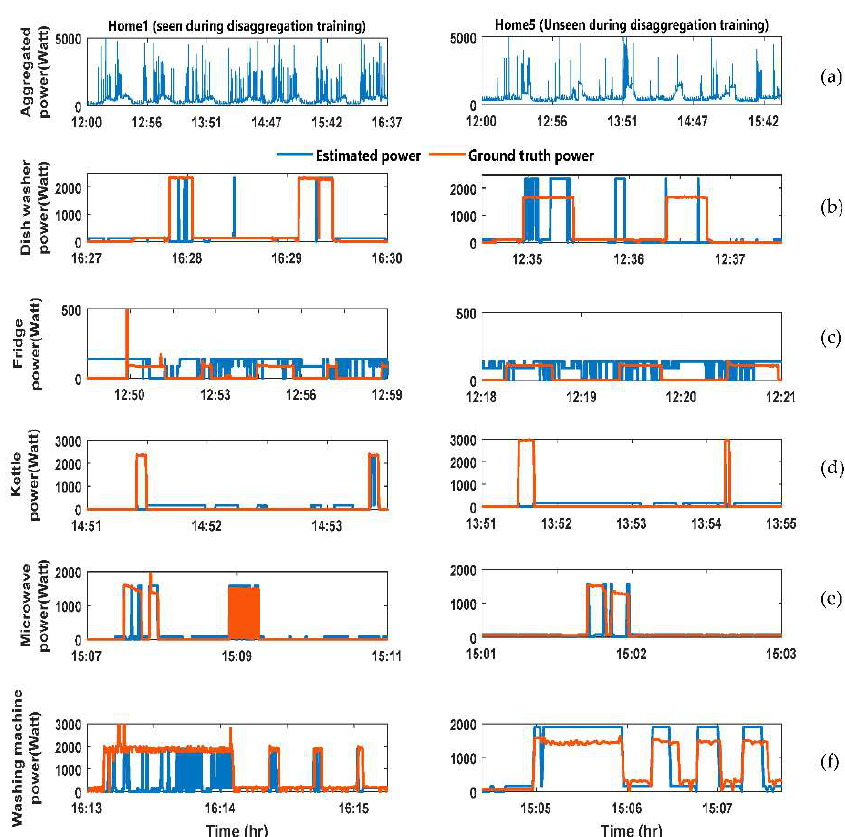
Figure 3. Shows the energy disaggregation algorithm output by using Factorial Hidden Markov Model (FHMM) technique. ( a ) Aggregated power consumption for the home; ( b ) dishwasher estimated and Ground truth power demand; ( c ) fridge estimated and Ground truth power demand; ( d ) kettle estimated and Ground truth power demand; ( e ) microwave estimated and Ground truth power demand; ( f ) washing machine estimated and Ground truth power demand.